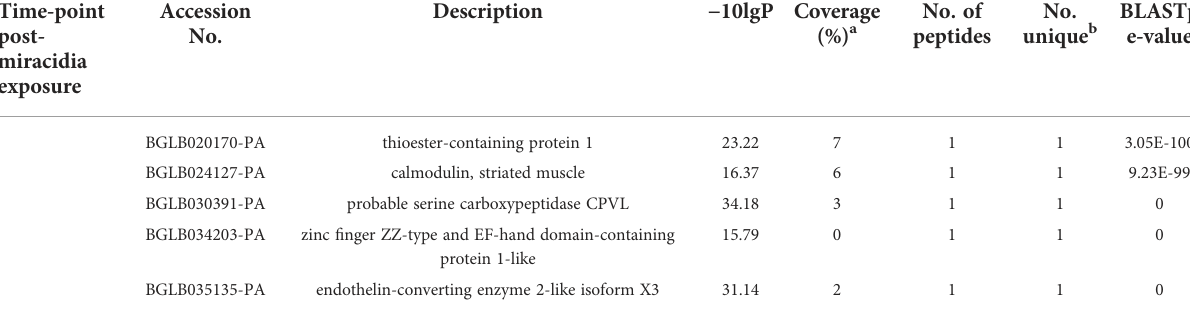
a The whole protein sequence coverage from the peptides identi fi ed with LC-MS/MS. b The number of identi fi ed peptides unique to the protein. Details of coverage, peptide match number and BLAST con fi dence (e-value) are